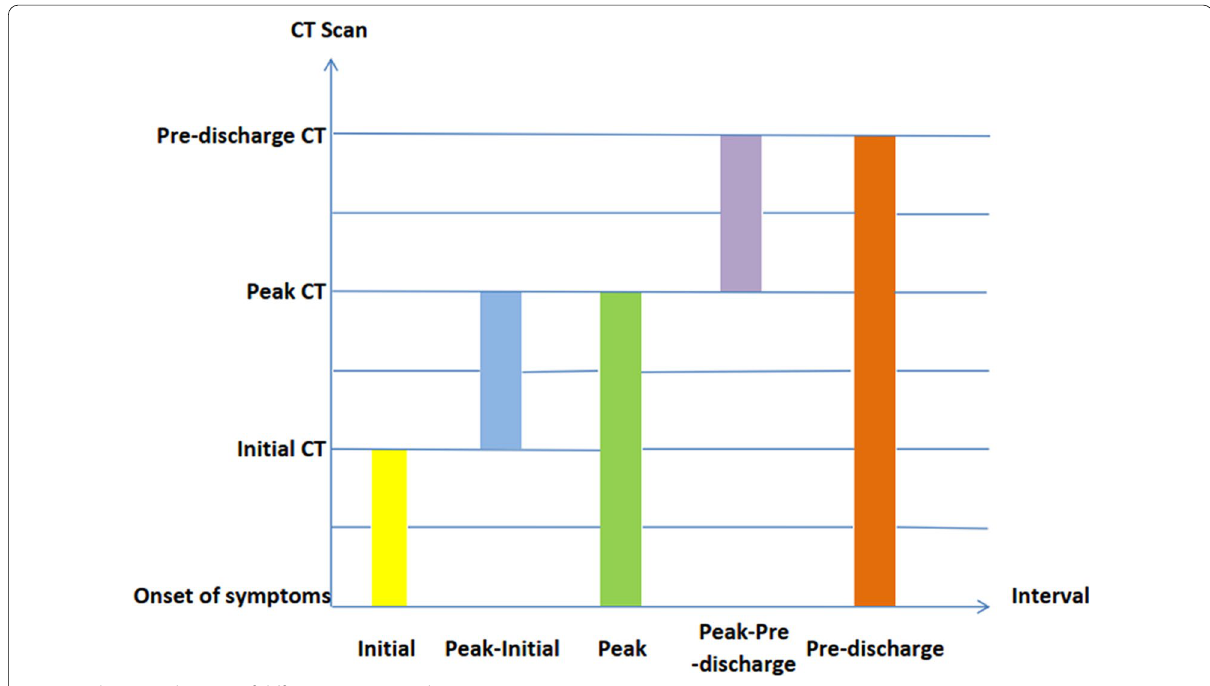
Fig. 1 Schematic diagram of different time